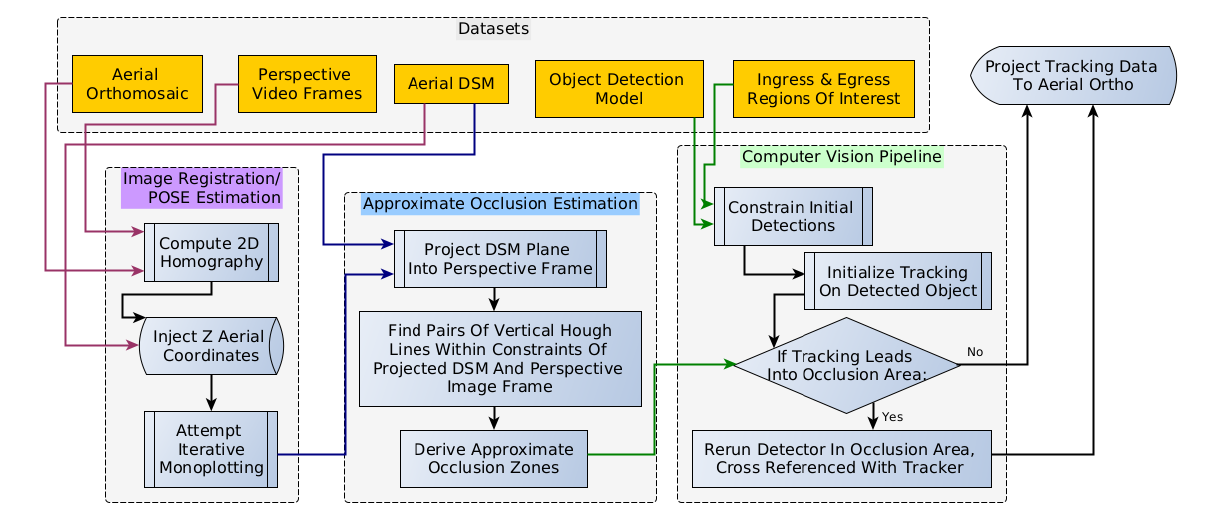
Figure 3. A high-level breakdown of the methodology and how the processes interact with one another in terms of data